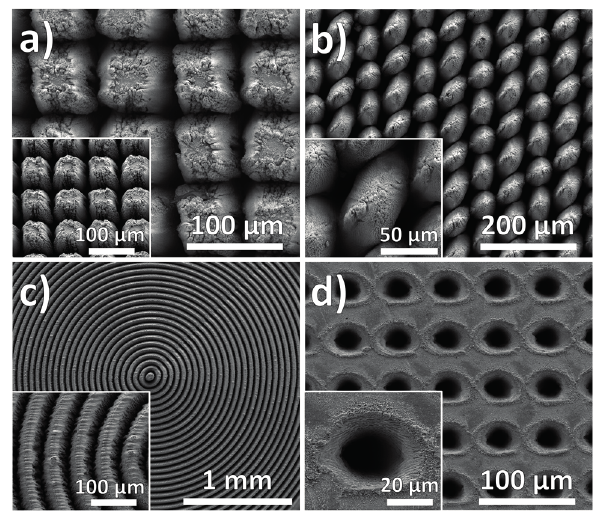
Figure 11. SEM micrographs of: ( a ) square pillar, inset: sample tilted at 20° angle; ( b ) parallelogram structures in a hexagonal arrangement, inset: zoomed in view; ( c ) circular grooves, inset: zoomed in view; and ( d ) micro hole pattern on Cu, inset: zoomed in